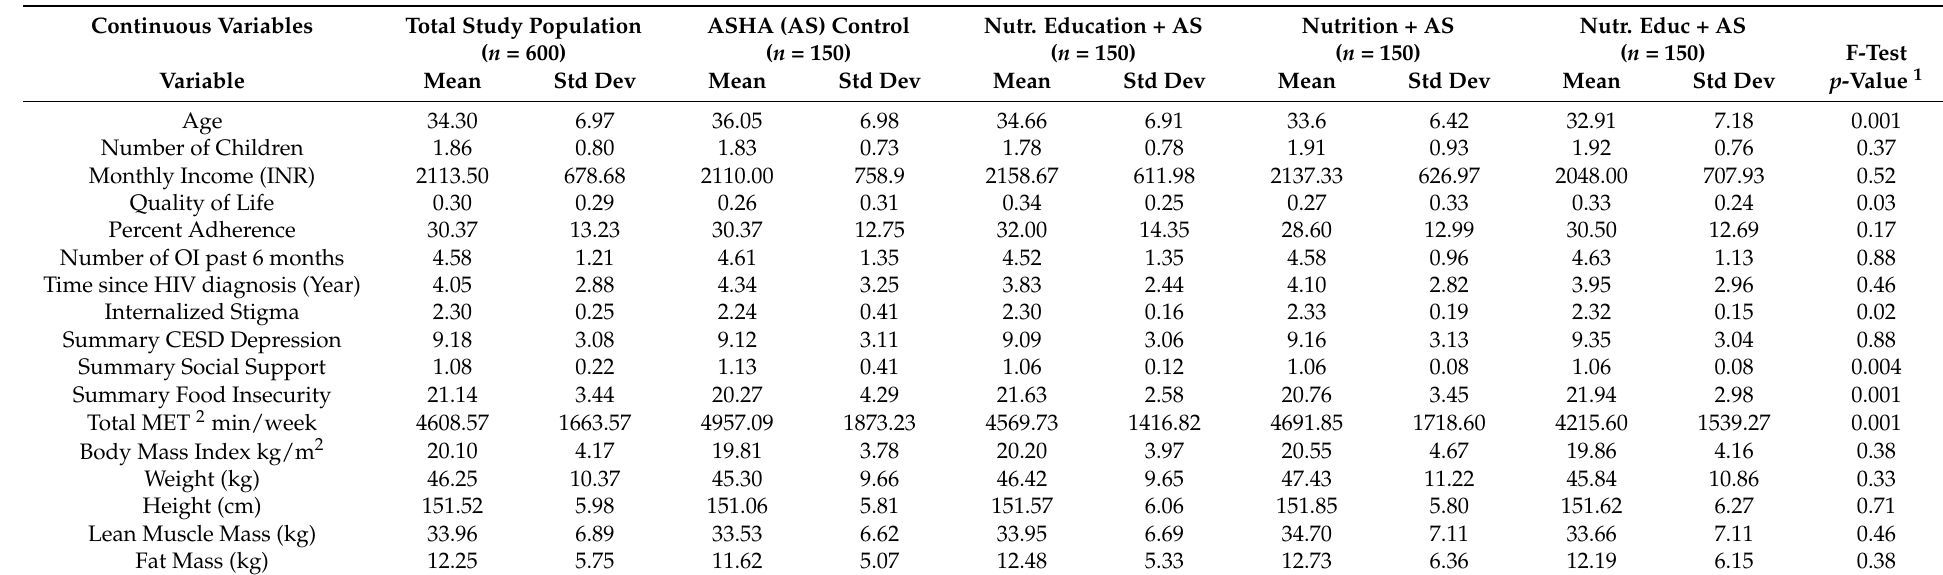
Table 1. Description at Baseline of Total Study Population According to Group